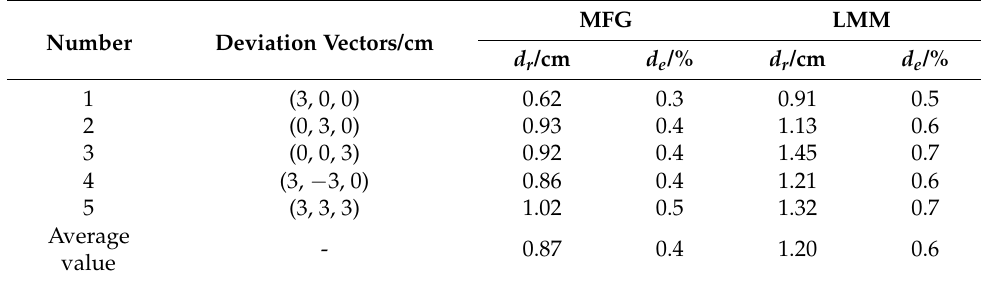
Table 4. The results of the model experiments with different deviation